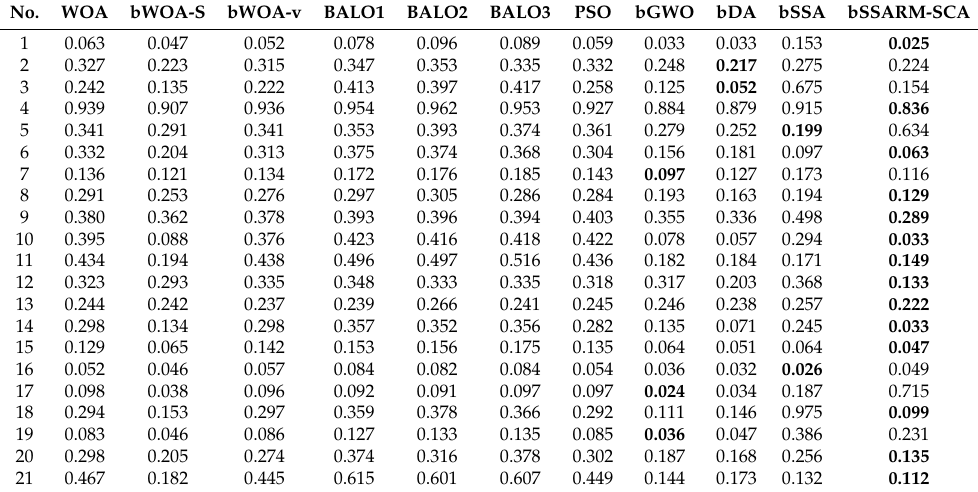
Table 10. Mean fitness statistical metric using small initialization with the 21 utilized datasets.